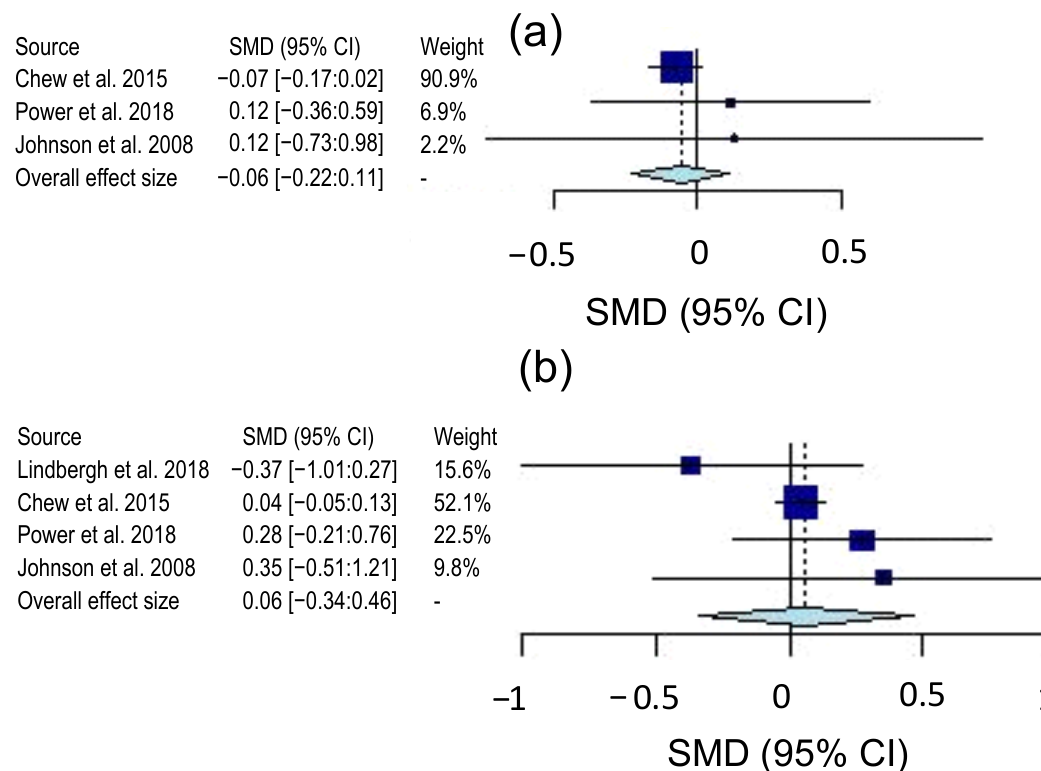
Figure 4. Forest plots of the cognitive domain test scores from lutein supplements only: ( a ) executive function and ( b ) memory. All plots express effect size as Hedge’s g SMD with 95% confidence interval and study weight.